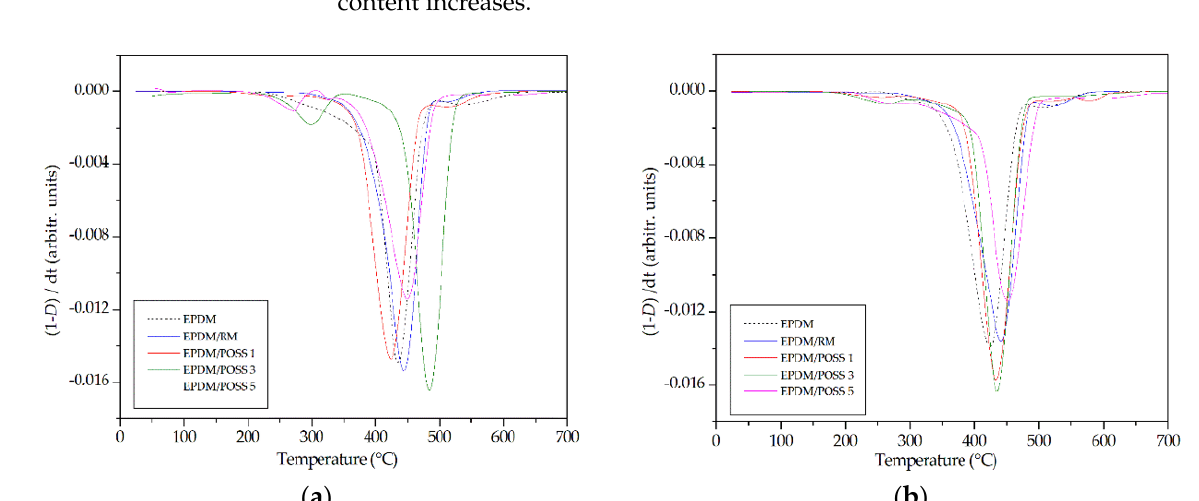
Figure 4. Derivative Thermogravimetric curves for the EPDM formulations. ( a ) unirradiated samples; ( b ) the samples subjected to a γ -dose of 50 kGy.